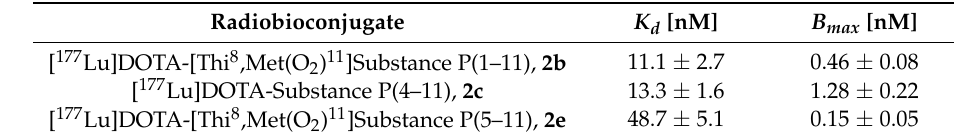
Figure 7. Specific binding of 2b , 2c and 2e radiobioconjugates performed on the U373 MG cell line expressing the NK-1 receptor. Table 2. Biological properties of selected radiobioconjugates.